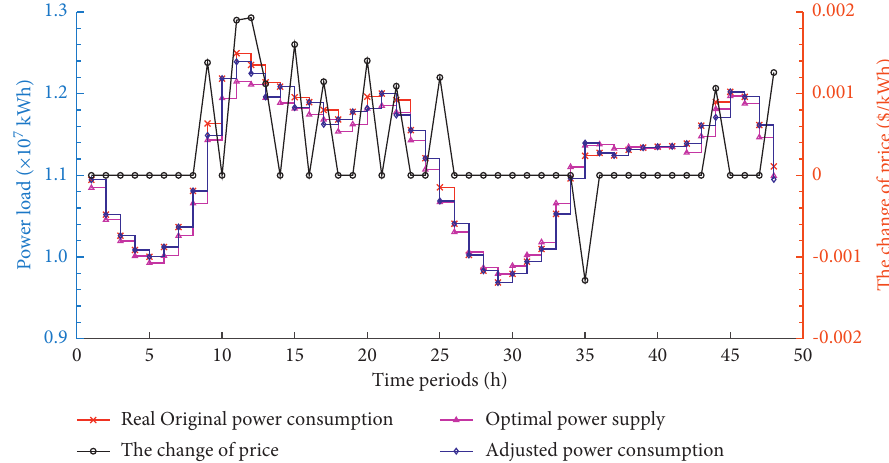
Figure 3: Power load after adjustment (red solid lines with asterisks denote real original power consumption, magenta solid lines with triangle markers indicate optimal power supply, and blue solid lines with point markers depict adjusted power consumption) and the change of price (black solid lines with circle markers denote the change of